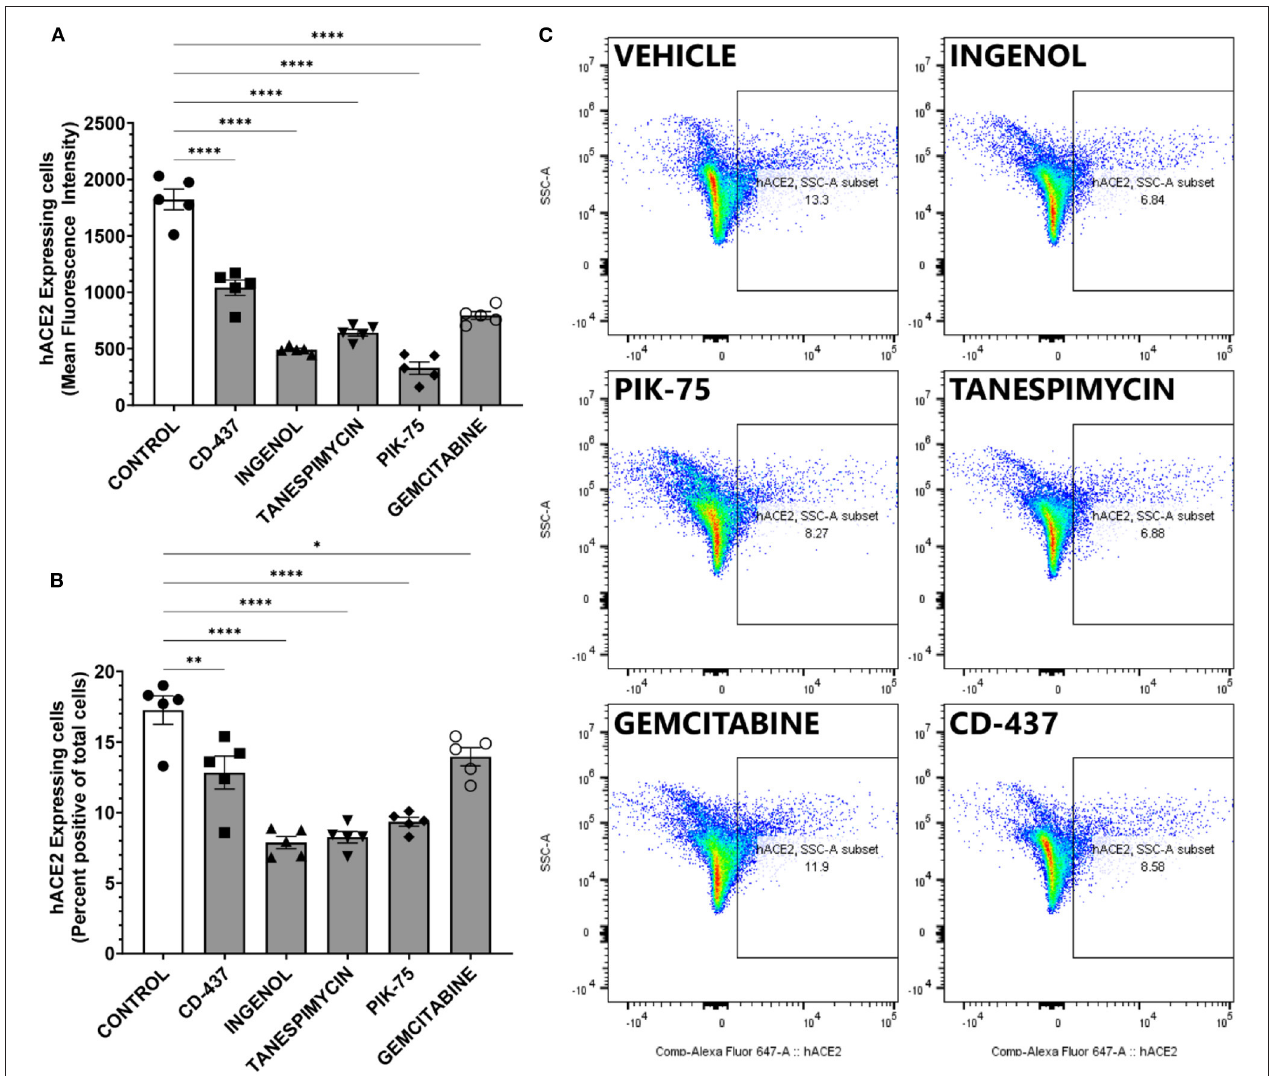
FIGURE 6 | ACE2 expression measure by FACS in BEAS-2B treated with the 5 repurposing candidates. (A) mean ACE2 expression ( n = 5). (B) ACE2 positive ratio. Error bar means standard deviation ( n = 5). * p < 0.05, ** p < 0.01, **** p < 0.0001. (C) Representative scatter plot showing percent positive ACE2 surface expression in BEAS-2B